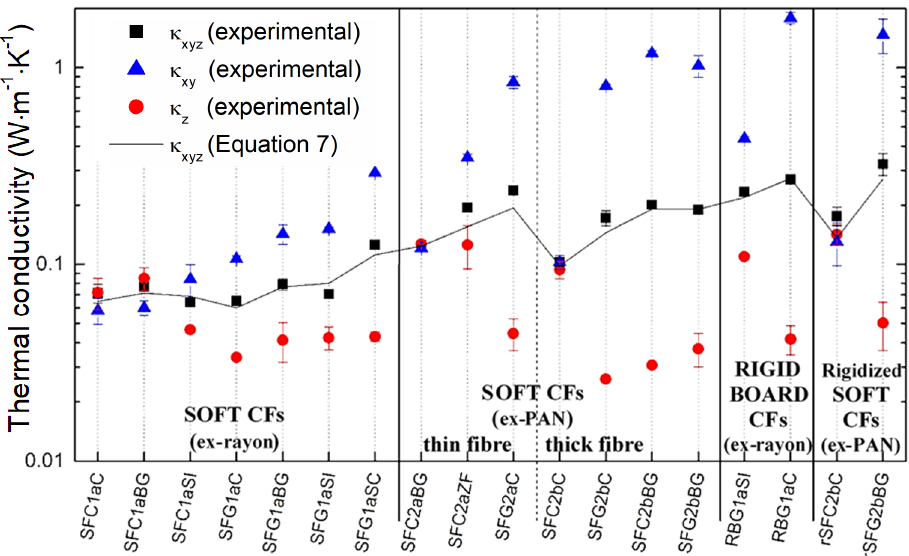
Figure 11. Thermal conductivity values of all commercial fibrous carbons measured by either isotropic mode (black squares— κ xyz ) or anisotropic mode (blue triangles for the IP direction— κ xy , and red circles for the OP direction— κ z ); the black solid line represents the calculated κ xyz from the separate measurements of κ xy and κ z , using Equation (7).